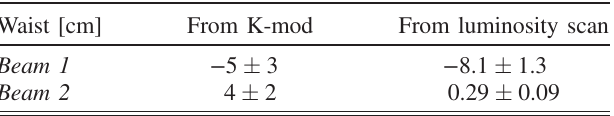
TABLE I. Comparison of the average over 5 measurements of the vertical waist displacements measured by K-modulation and the waist obtained using the luminosity scans. Waist [cm] From